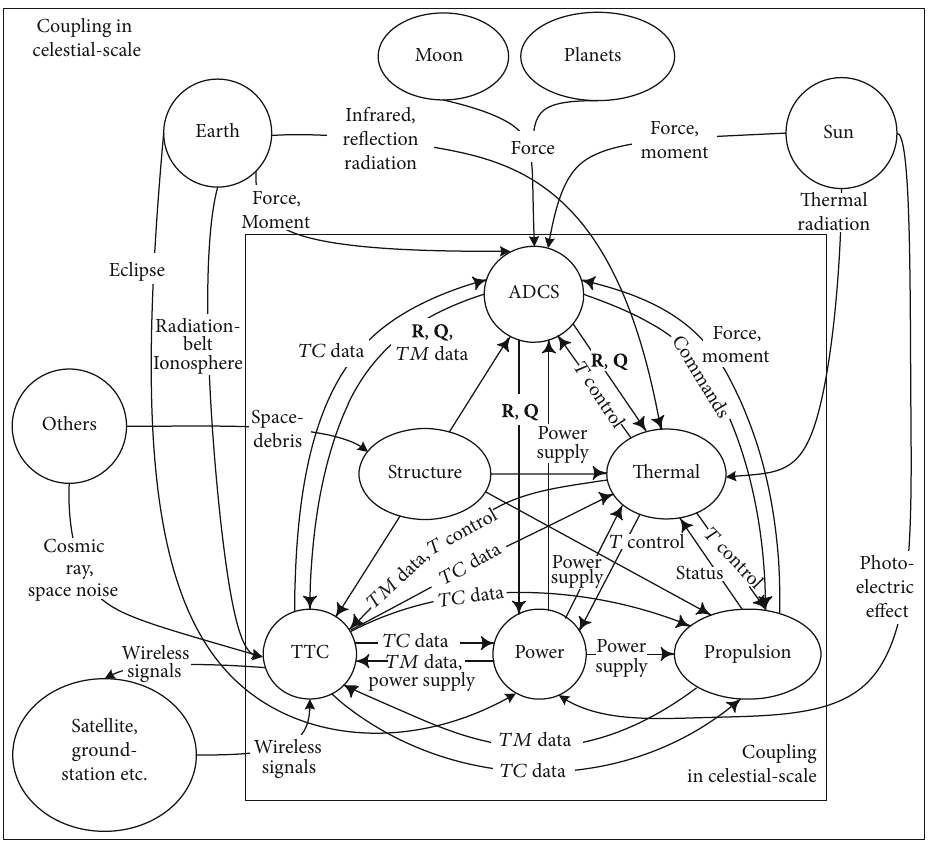
Figure 4: Coupling relationship in celestial- and satellite-scale. TM is short for telemetry. TC is the abbreviation for telecommand. T represents the temperature of